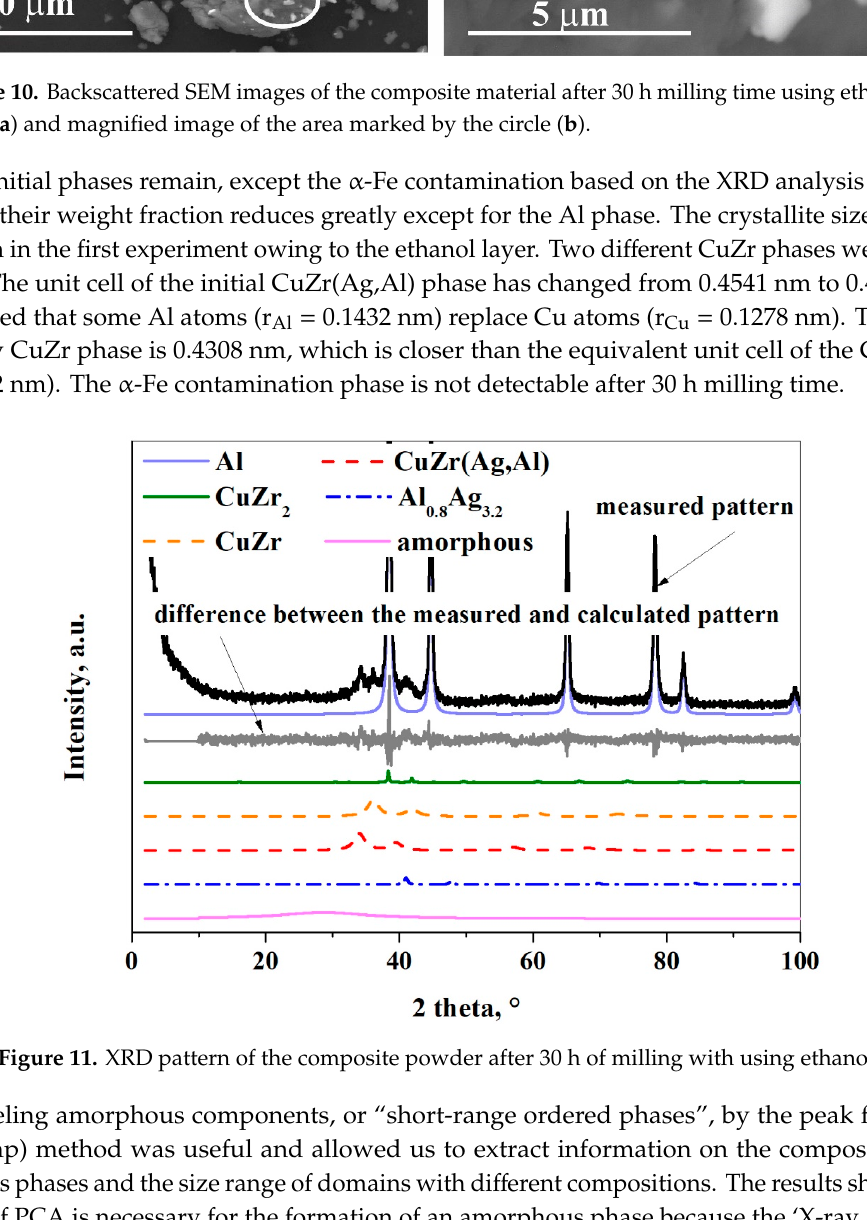
Figure 11. XRD pattern of the composite powder after 30 h of milling with using ethanol.